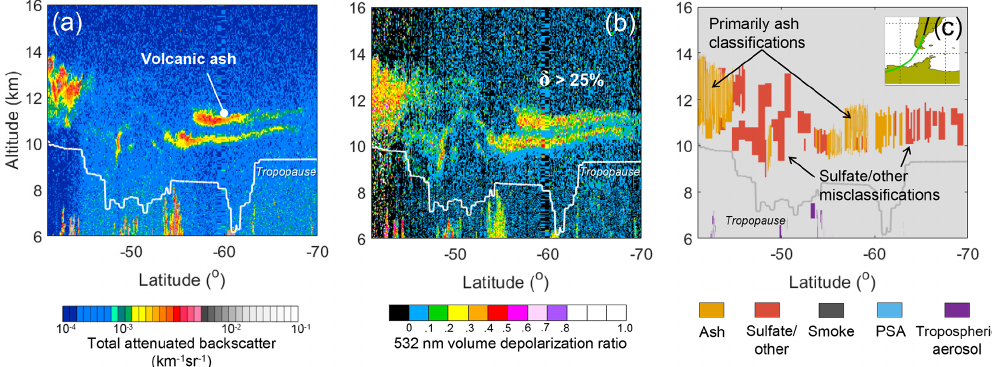
Figure 2. Volcanic ash plume from the June 2011 Puyehue-Cordón Caulle eruption observed on 16 June 2011 at ∼ 05:45UTC, southwest of Argentina: (a) 532nm total attenuated backscatter, (b) 532nm volume depolarization ratio, and (c) V4.1 aerosol subtype classification from the level 2 vertical feature mask. Inset map shows the CALIOP ground